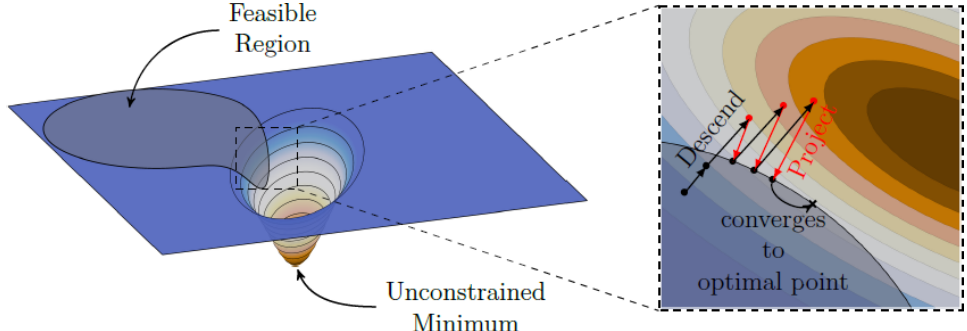
Figure 1. Projected gradient method. Each gradient descent step is projected back into a feasible set. In this manner, the solution becomes regularized, as the solution size cannot lie outside the feasible set. If the feasible set is convex, the solution will converge to an optimal point within the set. Image adapted from [33] (CC